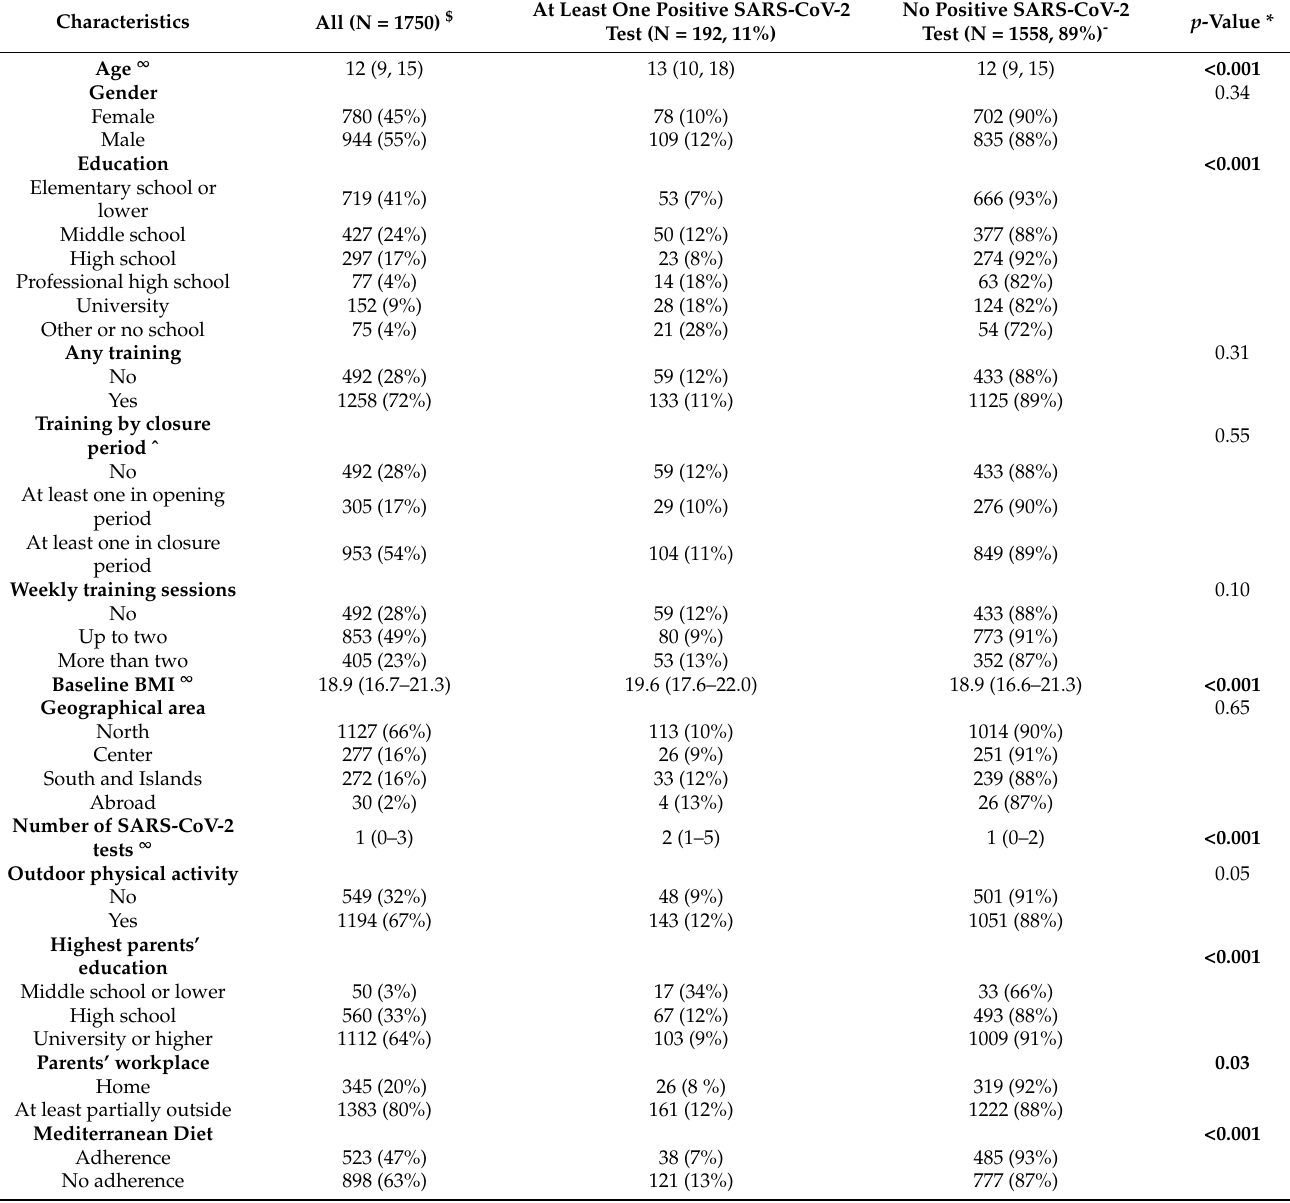
Table 1. Characteristics of the study population according to the absence or presence of at least one positive SARS-CoV-2 test in the whole study